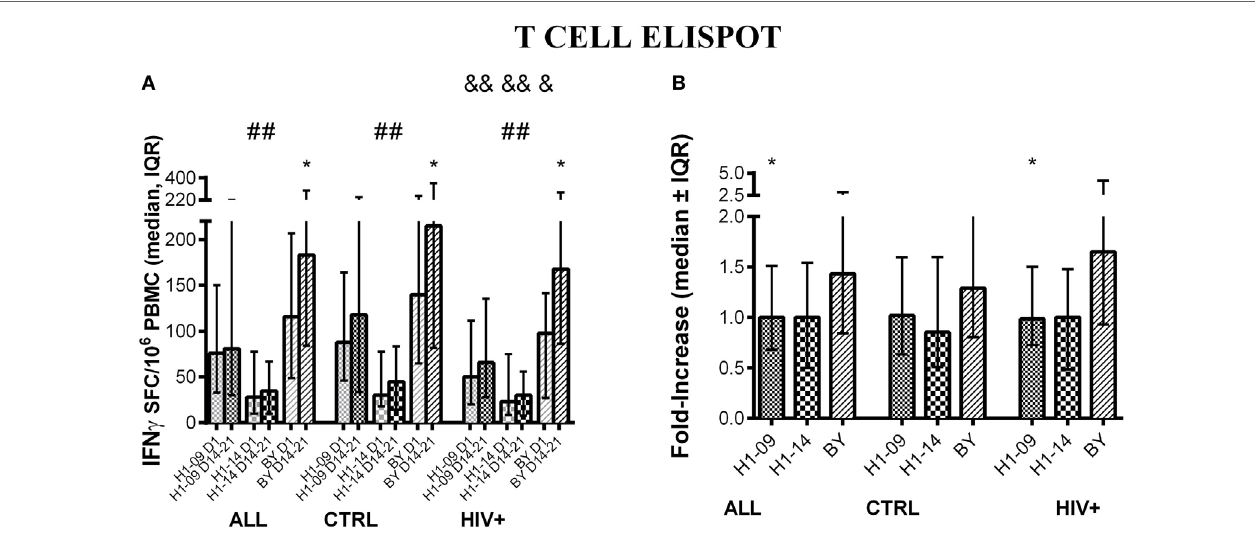
FigUre 1 | T-cell responses to laiV4 measured by elisPOT . The data were derived from 45 HIV-infected and 55 uninfected individuals. (a) Absolute responses in each group of participants, as indicated below the abscissa, at V1 (before vaccination) and V4 (14–21 days after vaccination) and against the viruses indicated in the labels of the abscissa. Asterisks (*) indicate significant differences between pre- and post-vaccination. Hash tags (#) indicate significant differences between H1N1-09 and H1N1-14. And symbols (&) indicate significant differences between HIV-infected and uninfected participants. (B) Fold-increases from pre- to post-vaccination. Asterisks (*) indicated significant differences between H1N1-09 and